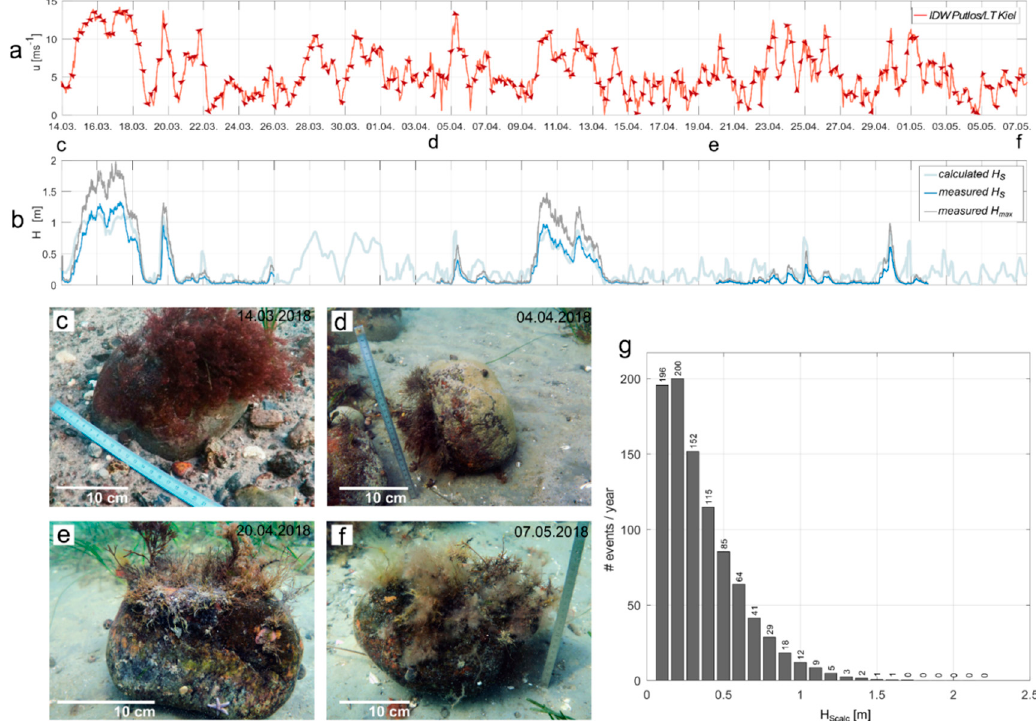
Figure 4. ( a ) Recalculated wind velocities and directions by inverse distance weighting (IDW) for the period 14 March–7 May 2018 using data from Kiel Lighthouse and Putlos (DWD stations). ( b ) Corresponding measured and calculated wave heights. ( c – f ) Underwater images of the same cobble (Ø 20 cm) taken at intervals ( c – f ) highlighted in the time series above. ( g ) Average probability distribution of the number of wave events with significant wave heights (H S, calc. ) divided into 10 cm classes (2010 − 2019).